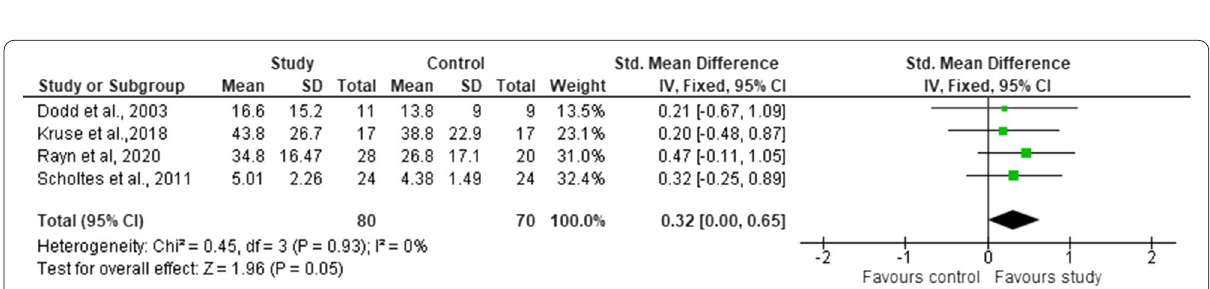
Fig. 6 Forest plot of comparison between study and control groups regarding plantar flexors strength —